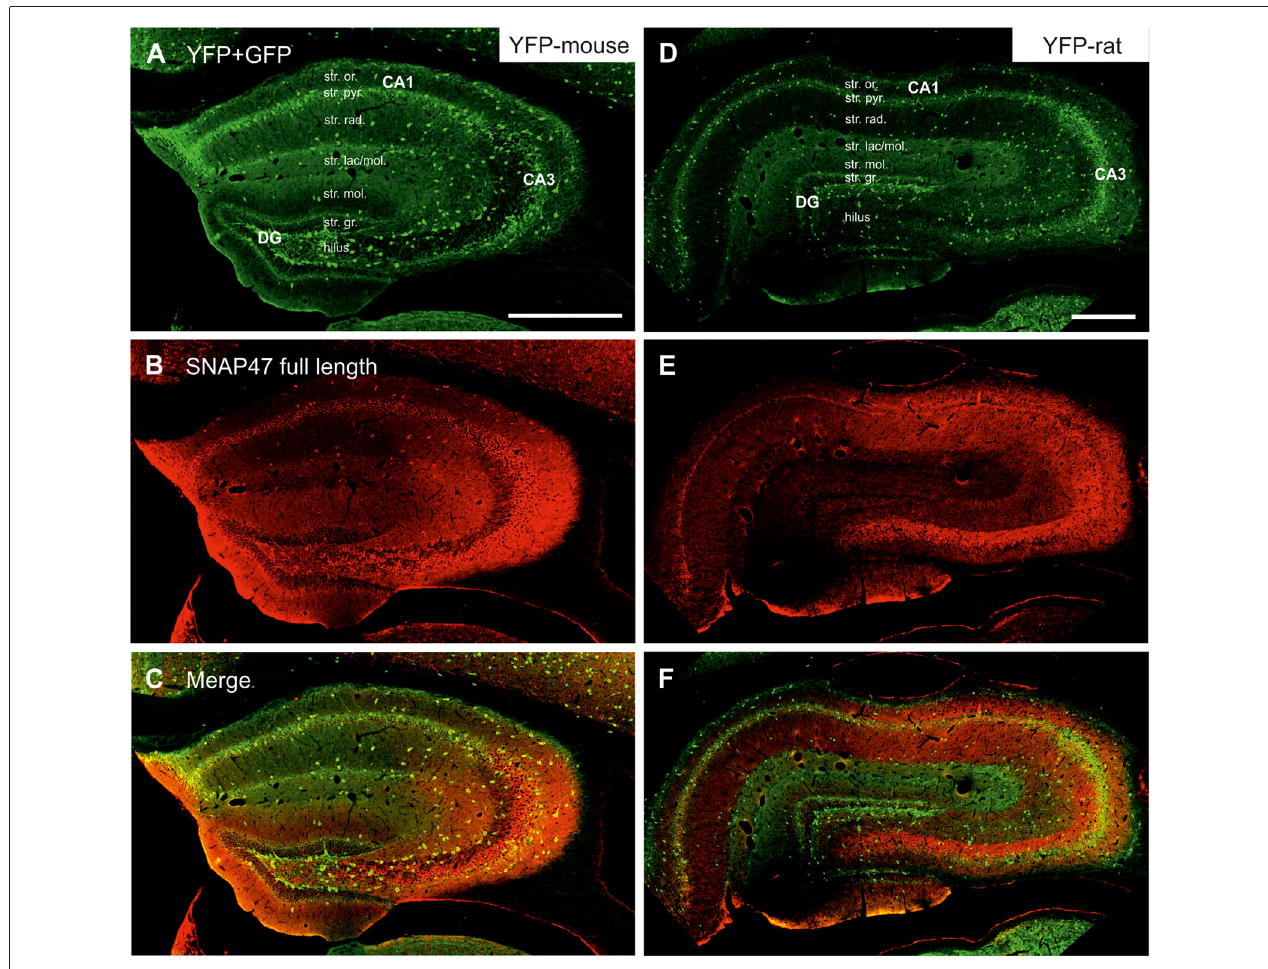
FIGURE 3 | Immunofluorescence labeling pattern of SNAP47 in the hippocampus of VGAT-Venus(yellow fluorescent protein, YFP) transgenic mice and rats. (A–C) Confocal images of double immunolocalization for YFP and SNAP47 in the hippocampus of VGAT-Venus(YFP) mouse. Note that the scattered YFP positive interneurons (INs; A ) are positive for SNAP47 ( B , superimposed images in C ). (D–F) Confocal images of double immunolocalization for YFP and SNAP47 in the hippocampus of VGAT-Venus(YFP) rat. Note that in contrast to the mouse, the scattered YFP positive INs (D) are not strongly labeled for SNAP47 ( E , superimposed images in F ) in the rat. Scale bars represent, (A–F) , 500 µ